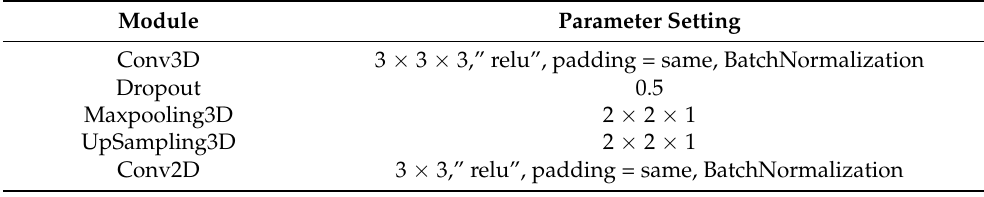
Table 1. Parameter settings.